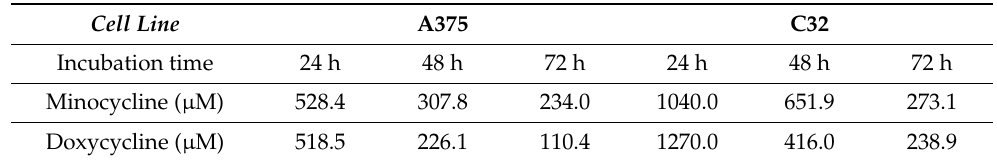
Figure 1. Screening analysis of melanoma cell proliferation after incubation with minocycline ( a , c ) and doxycycline ( b , d ). A375 and C32 melanoma cell were treated for 24 h, 48 h and 72 h. Mean values ± SD from three independent experiments are presented. * p < 0.05; ** p < 0.005 vs. control; ^ p < 0.05; ^^ p < 0.005 vs. 24 h; # p < 0.05; ## p < 0.005 vs. control 48 h. Table 1. The calculated EC 50 values for minocycline and doxycycline after 24 h, 48 h and 72 h treatment of A375 and C32 melanoma